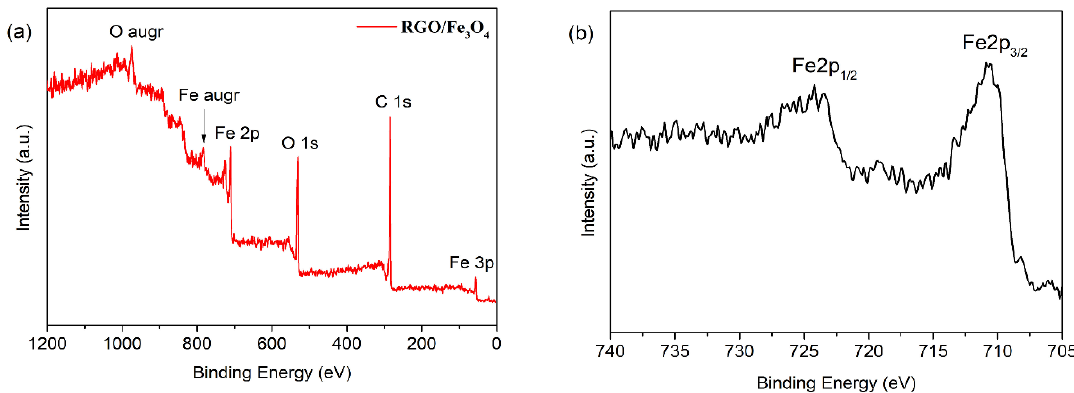
Figure 1. X-ray photoelectron spectroscope (XPS) spectra of reduced graphene oxide (RGO) / Fe 3 O 4 nanocomposite: ( a ) full spectrum, ( b ) Fe2p high resolution spectrum.